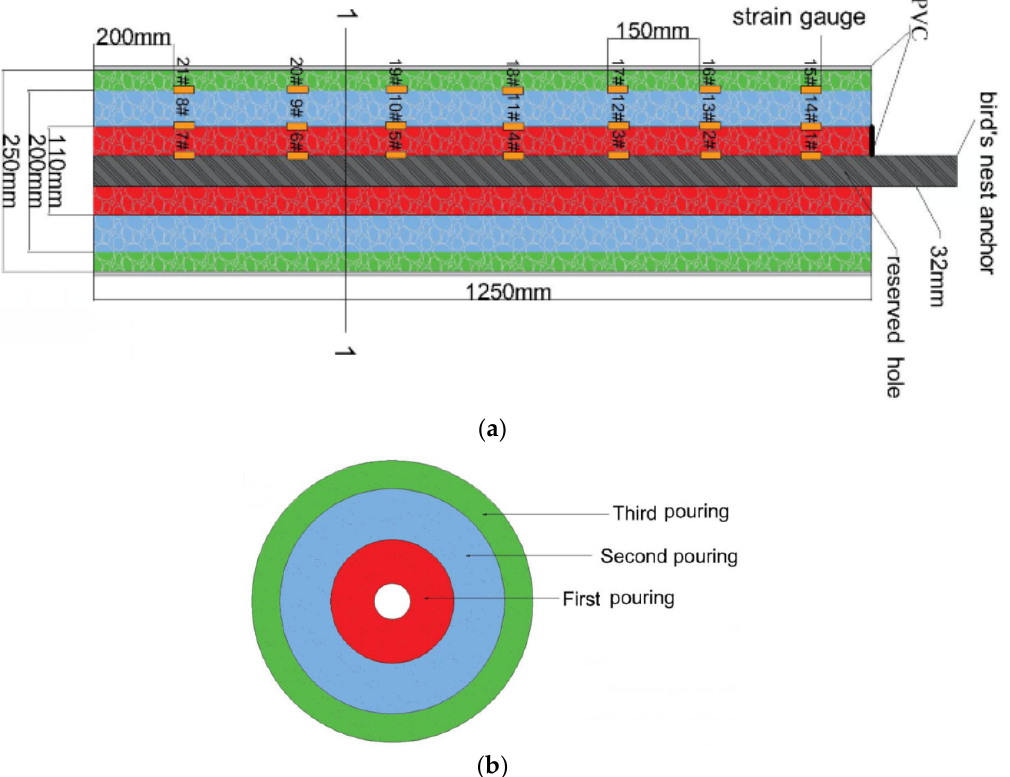
Figure 2. Depiction of the finished anchorage structure. ( a ) Sketch of the anchorage structure; ( b ) 1–1 cross-section program of the anchorage structure.